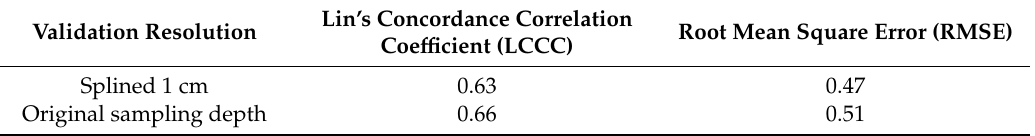
Table 3. Validation prediction statistics for the soil pH model using leave-one-site-out cross-